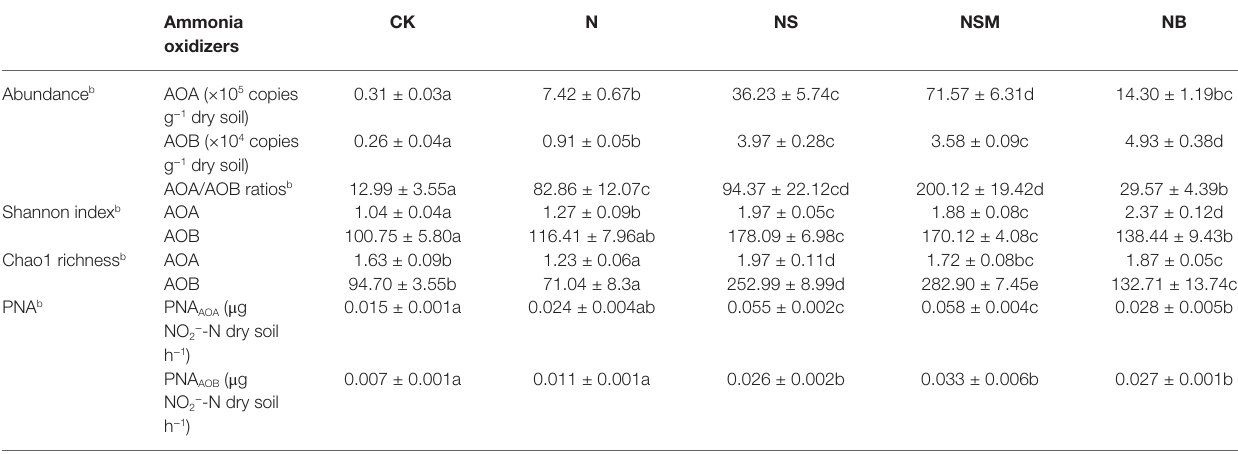
TABLE 1 | The abundance, diversity, and potential nitrification activity (PNA) of AOA and AOB populations under the five fertilization treatments. a